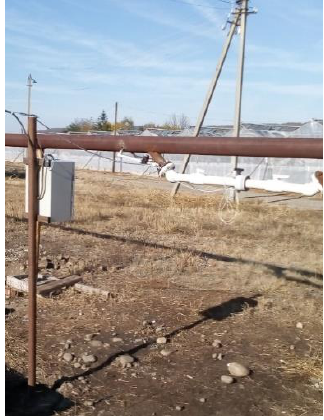
Figure 16. The automatic reagentless geothermal water treatment system control cabinet.